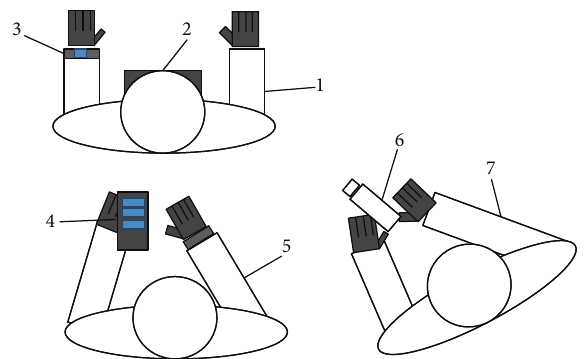
Figure 7: A conceptual setup of the study. 1: participant, 2: Vuzix Star 1200 [34], 3: Sony Smartwatch [32], 4: Sony Xperia Z [37] WozARd wizard side, 5: human operator, 6: Sony Handycam HDR- CX190 [38], and 7: test assistant.